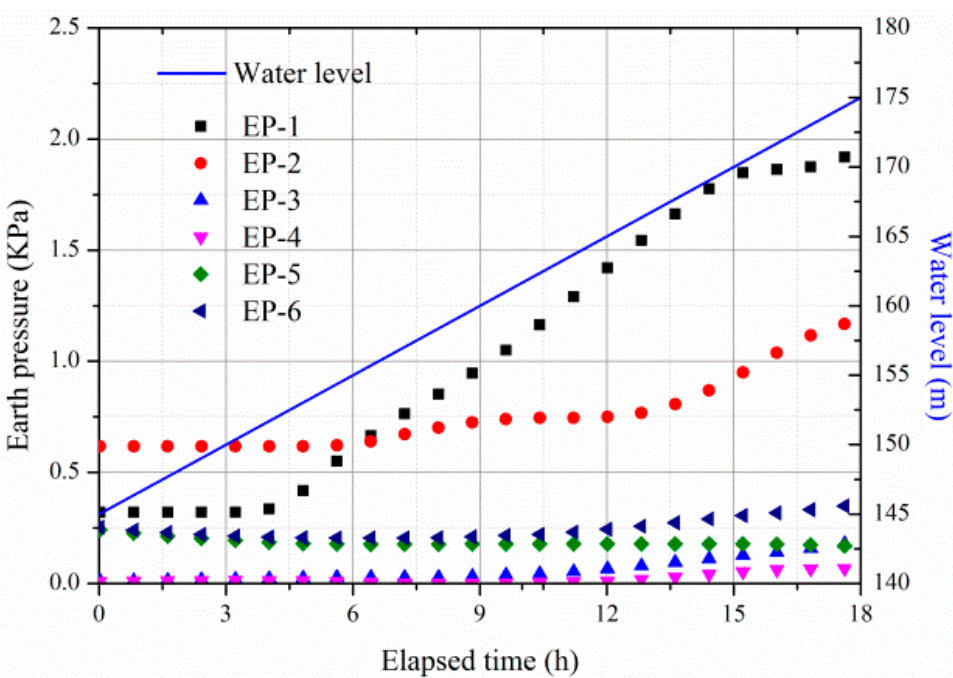
Figure 9. Soil pressure levels during the rises in the water levels.